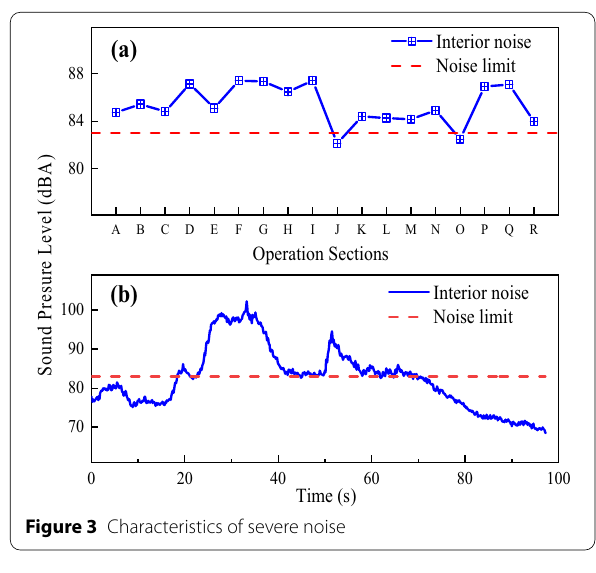
Figure 3 Characteristics of severe noise